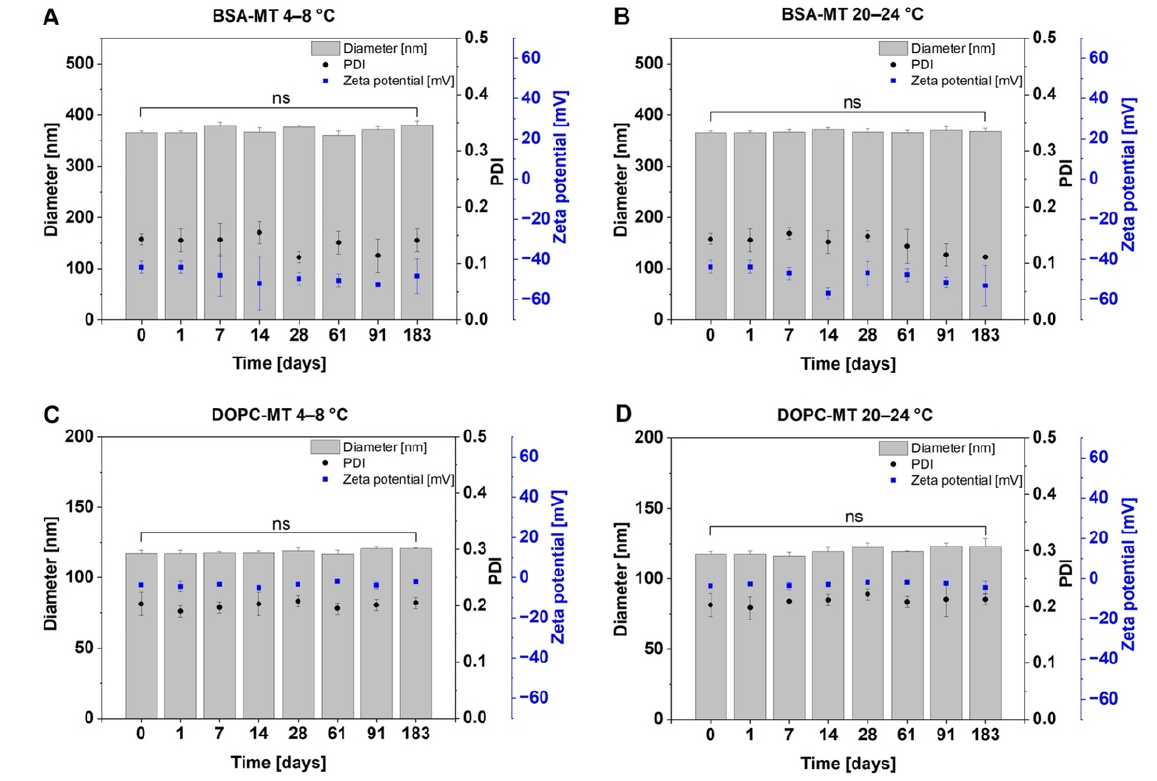
Figure 2. Colloidal stability analysis of albumin-stabilized mitotane (BSA-MT) and liposomal mitotane (DOPC-MT) under different storage conditions. Aliquots of the samples were stored at 4–8 °C (( A ) BSA-MT; ( C ) DOPC-MT) or 20–24 °C (( B ) BSA-MT; ( D ) DOPC-MT) for 6 months (183 days) and then analyzed for particle size, polydispersity index (PDI), and zeta potential. Significant differences were evaluated via one-way ANOVA and Dunnett’s post-hoc test (ns = not significant). Data are expressed as mean ± SD, n = 3.